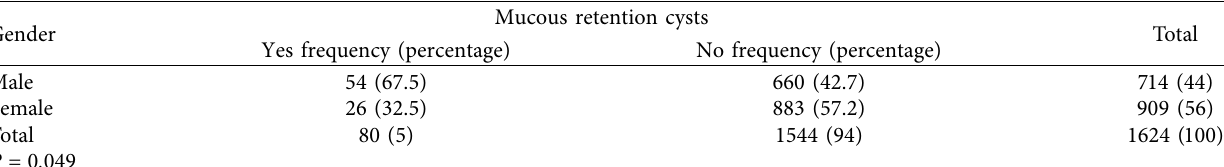
Table 3: The frequency of mucous retention cysts (MRCs) in the population studied relative to gender. Gender